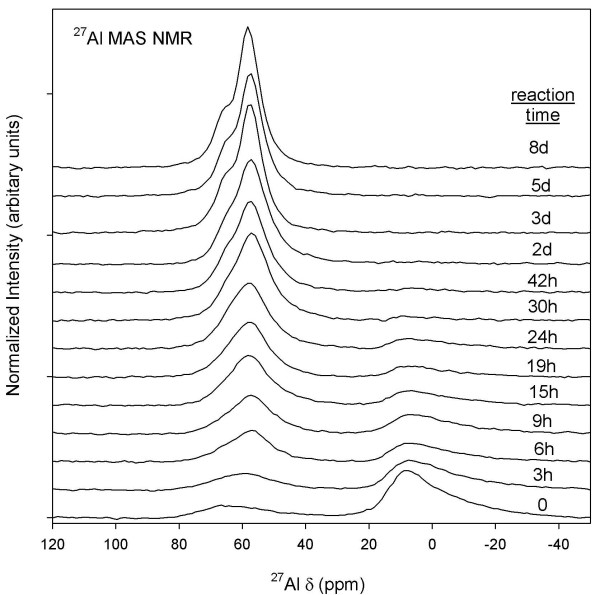
27Al MAS NMR of amorphous Al2O3 starting material ([6]Al ~ 9 ppm ; [4]Al ~ 62–70 ppm) and Al-CSH and tobermorite solids ([4]Al ~ 54–68 ppm) for the 10:1 batch reaction.